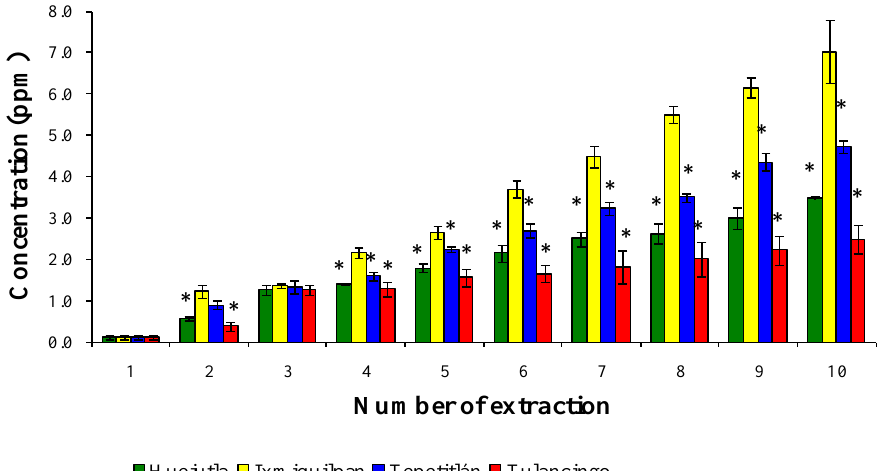
Figure 6. Concentration of Pb leached from the glass-clay containers into the chickpea puree. The bars show the mean values of the four regions with their standard deviations. * Indicates significant statistical differences with respect to the Ixmiquilpan region, which represents the highest concentration of the metal; p ≤ 0.05.